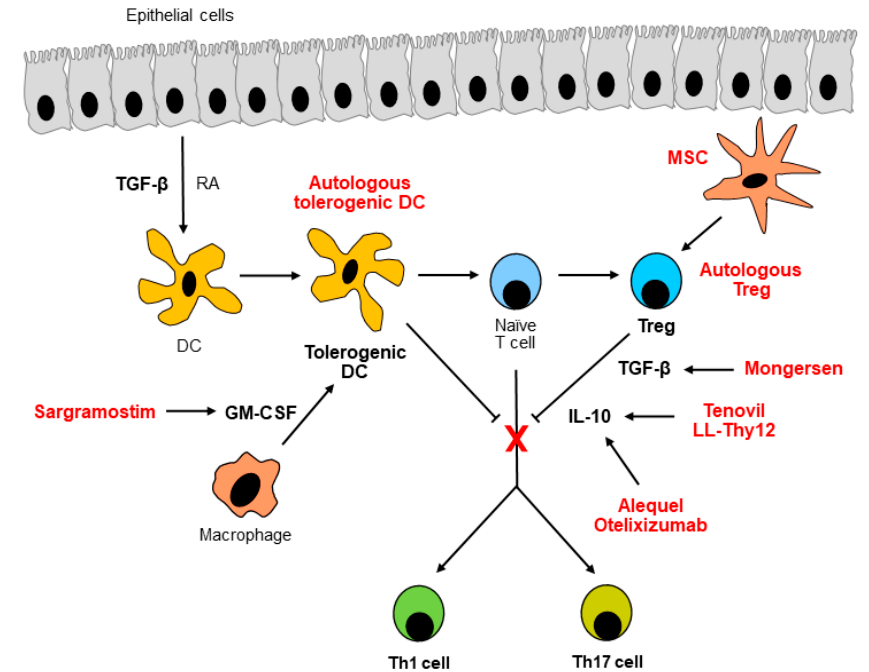
Figure 1. Schematic representation of the anti-inflammatory mechanisms dampening the inflammation in the gut. Upon stimulation of transforming growth factor (TGF)- β and retinoic acid (RA) from epithelial cells and granulocyte macrophage colony-stimulating factor (GM-CSF) from macrophages, dendritic cells (DCs) become tolerogenic, thus promoting the di ff erentiation of regulatory T cells (Tregs) from naive T cells in healthy gut. Sargramostim and autologous tolerogenic DCs resume the function of GM-CSF and tolerogenic DCs themselves, respectively. In addition to tolerogenic DCs, Tregs inhibit development of T helper 1 (Th1) and Th17 cells by producing TGF- β and interleukin (IL)-10 in healthy gut. Autologous Tregs reinstate Treg function. Mongersen reactivates TGF- β signaling, whereas Tenovil, IL-10 administered through genetically-modified Lactobacillus lactis (LL-Thy12), Alequel, and otelixizumab restore IL-10. Mesenchymal stem cells (MSCs) induce an increase in the number of Tregs.